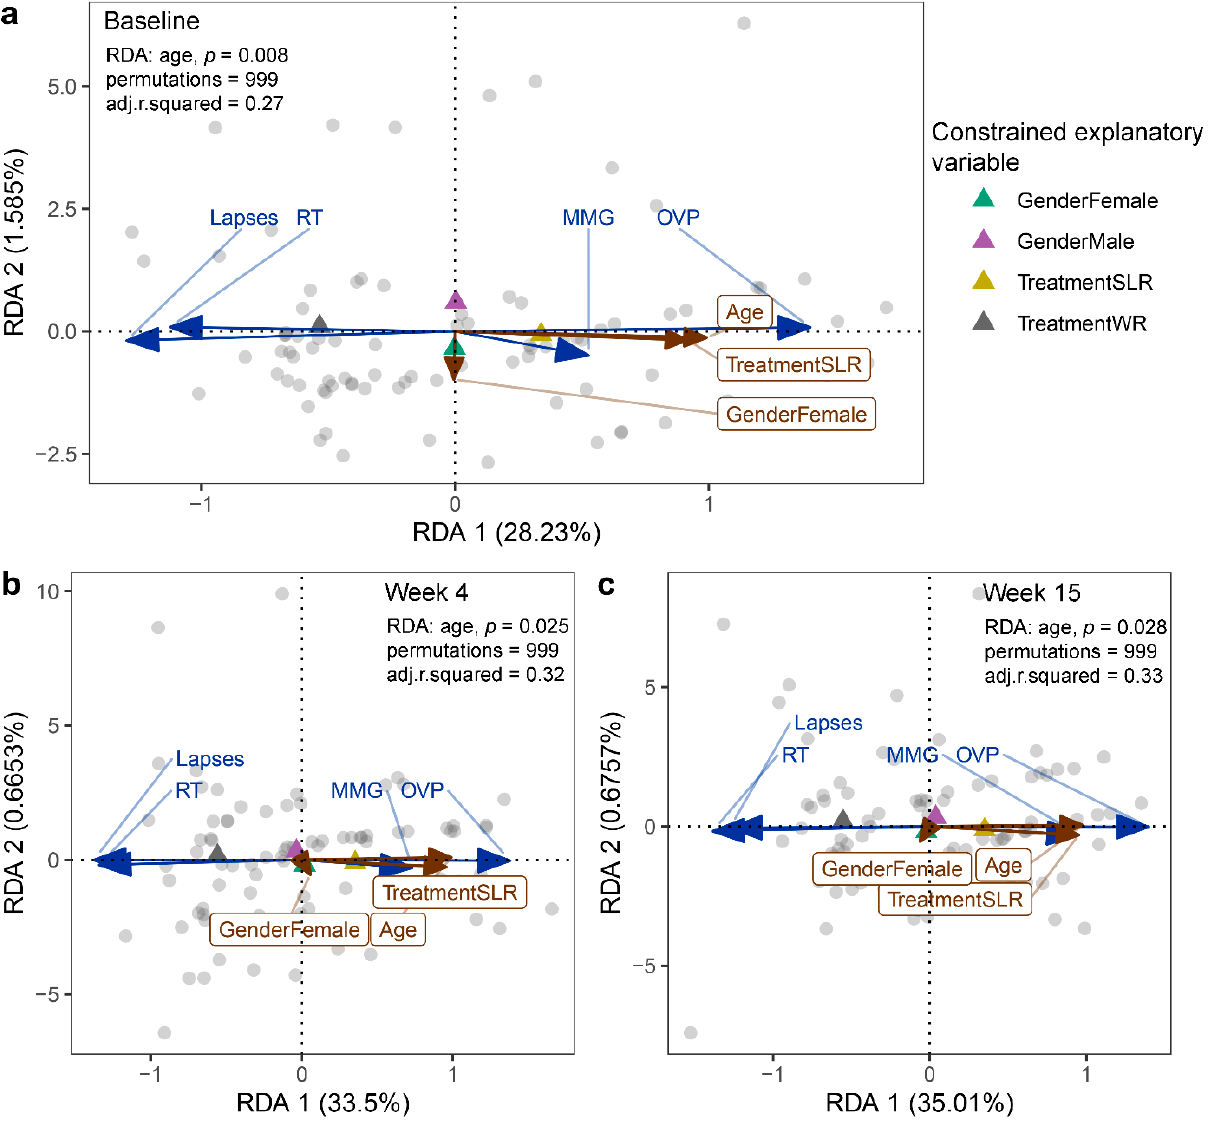
Figure 5. RDA plots displaying the effect of intervention on the cognitive performance of school-aged children at ( a ) the baseline, ( b ) Week 4, and ( c ) Week 15. Treatment, gender, and age were used as constrained explanatory variables, and cognitive performance was used as a response variable. Biplot arrows in the RDA plots represent cognitive performance (blue arrows) and constrained explanatory variables (brown arrows). A triangle denotes the centroid of each explanatory variable. The angle between a pair of vectors reflects their correlation. The significance of each constraint was assessed using an ANOVA-like permutation test. WR, white rice (control); SLR, Sinlek rice intervention; MMG, memory matching game; OVP, overall performance (%); RT, reaction times (millisecond); lapses (millisecond).